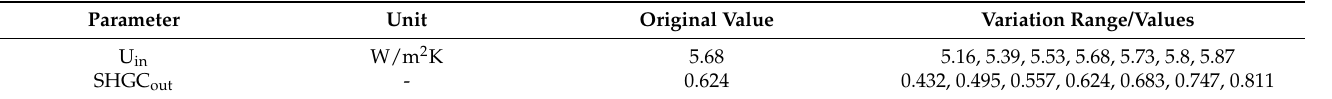
Table 3. Variation space of the most important parameters for